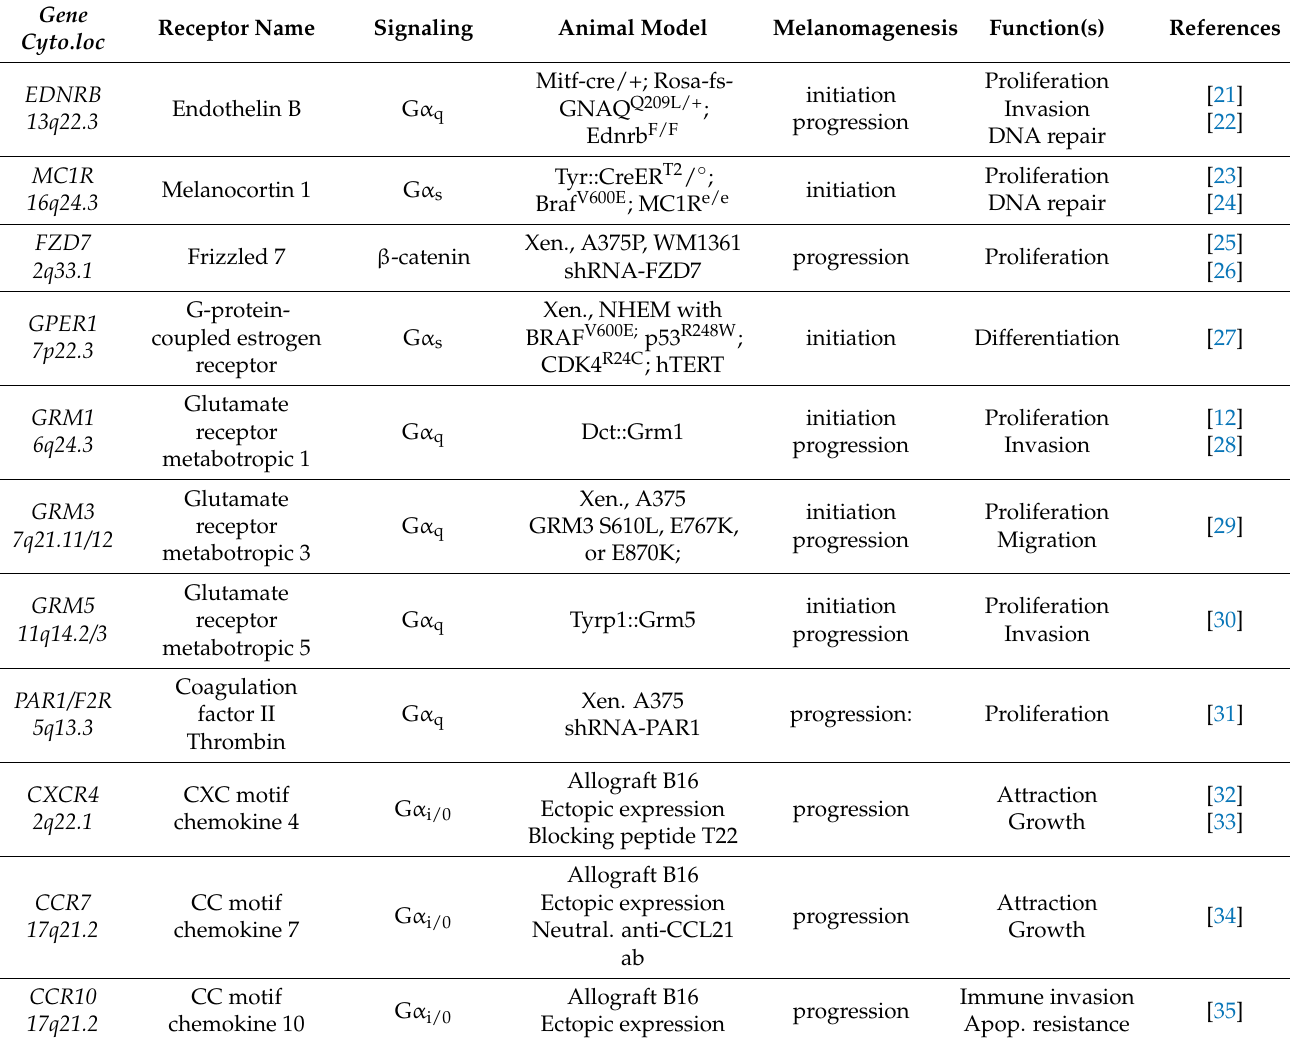
Table 2. GPCR and